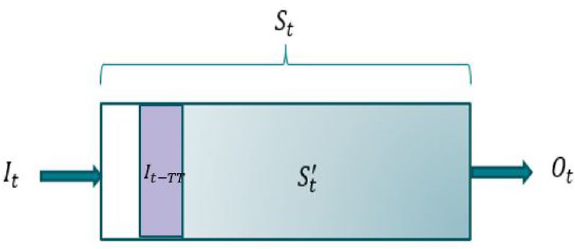
Figure 2. Residual storage schematic